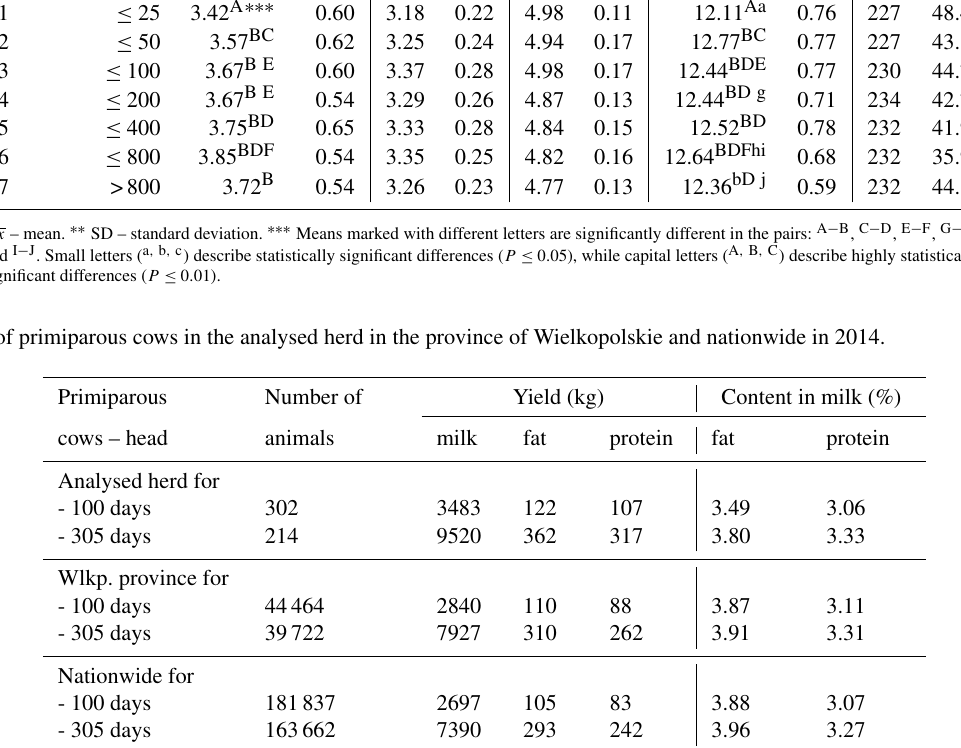
Contents in milk